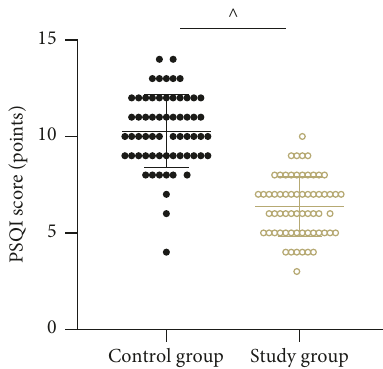
Figure 5: Comparison of postoperative night-time PSQI scores within the two groups (points). ^ represents a significant difference between the two groups.